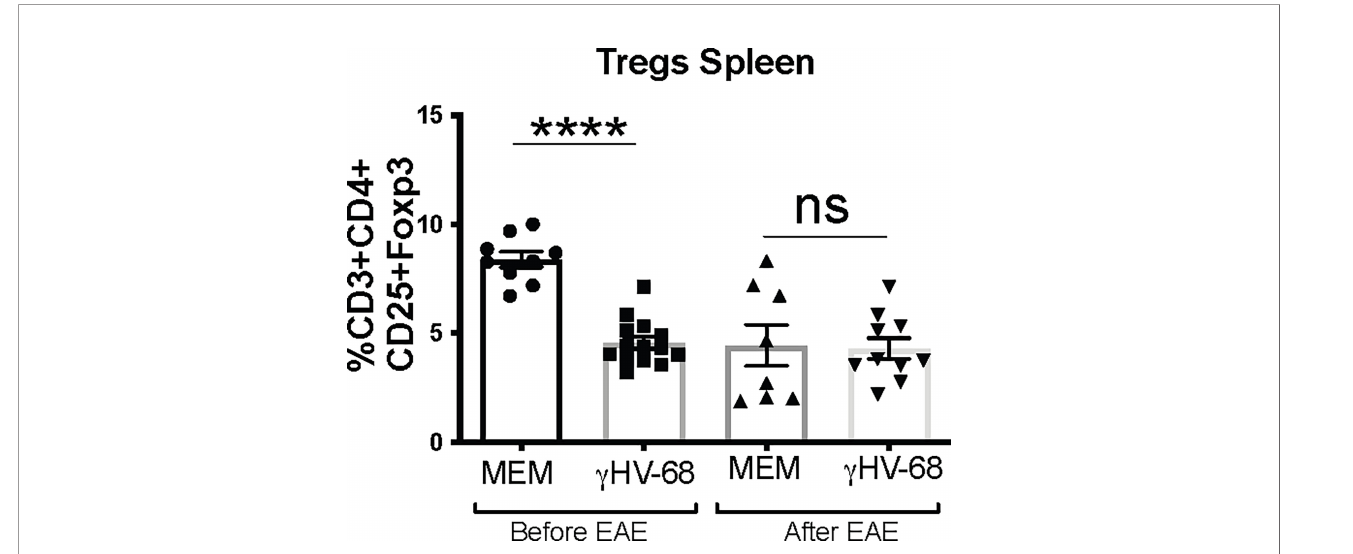
FIGURE 4 | Tregs from g HV-68 latently infected IFNARko mice are downregulated before and after EAE induction. IFNARko mice were infected with g HV-68. 5 weeks p.i. mice were induced or not with EAE, they were harvested at day 14 post induction, spleens were harvested and stained. Percentage of CD3 + CD4 + CD25 + Foxp3 + in the spleen. n= 8-10/group 2 separate experiments. Data analyzed with Student ’ s t-test: ****p<0.